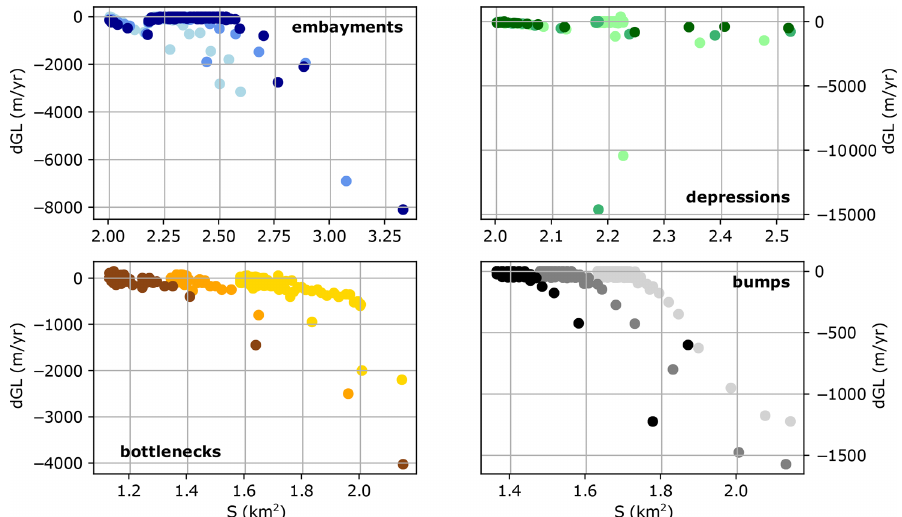
Figure A5. Correlation of dGL over S including